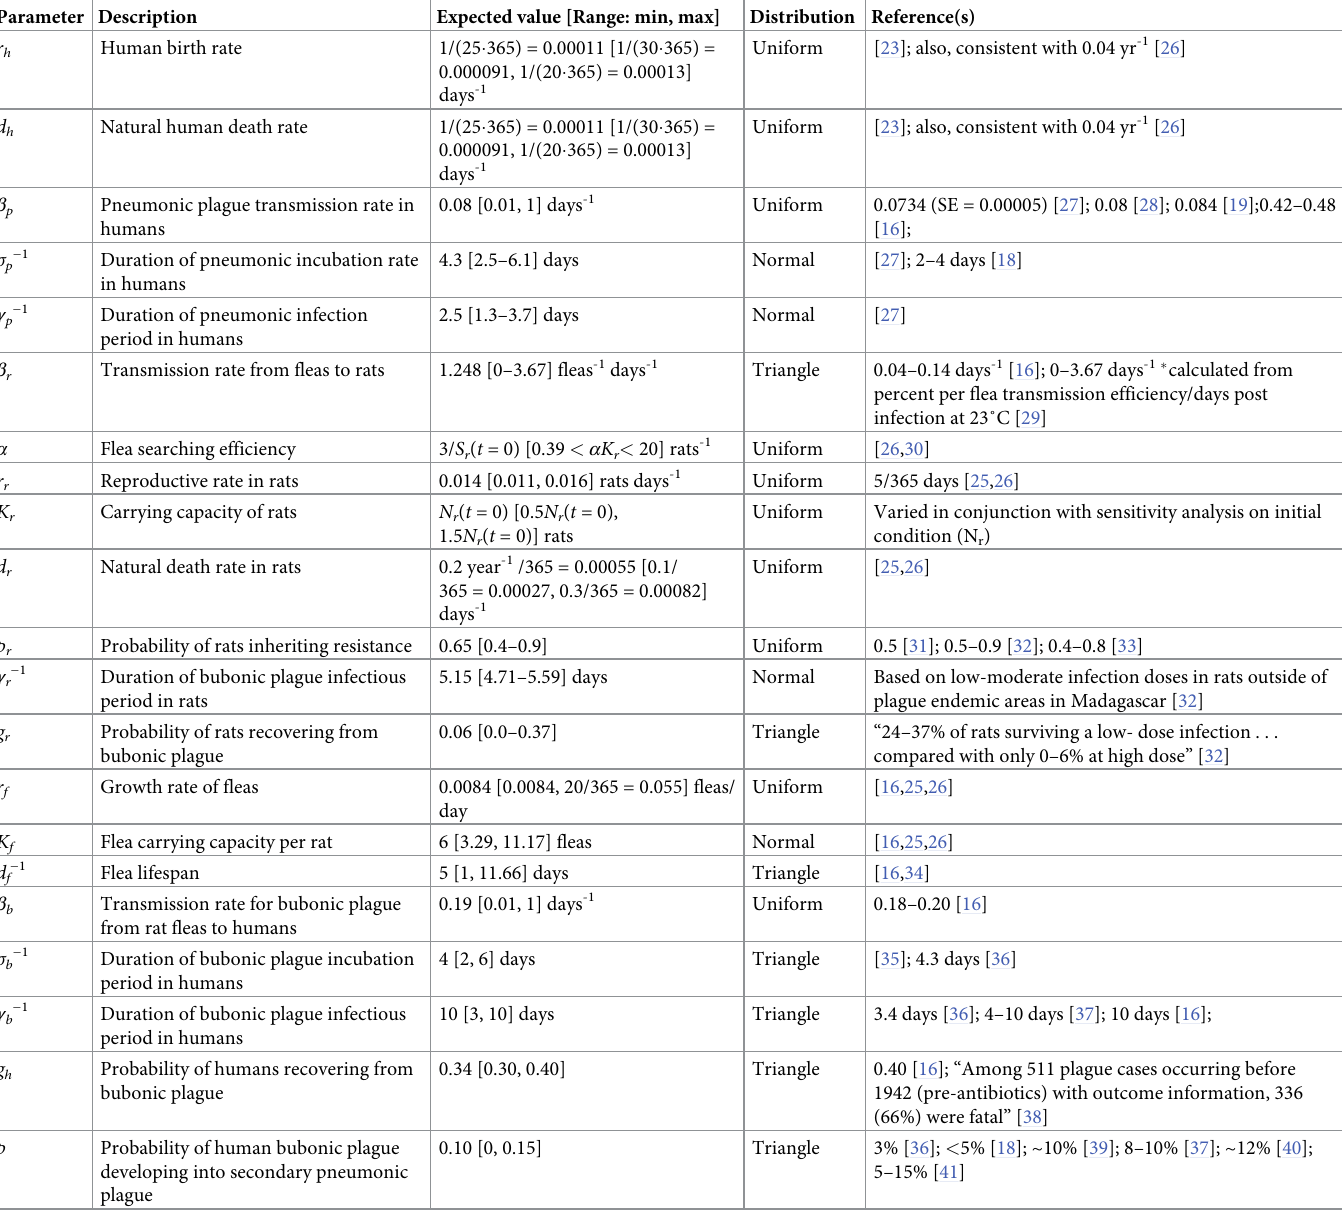
Table 1. Expected parameter values derived from the